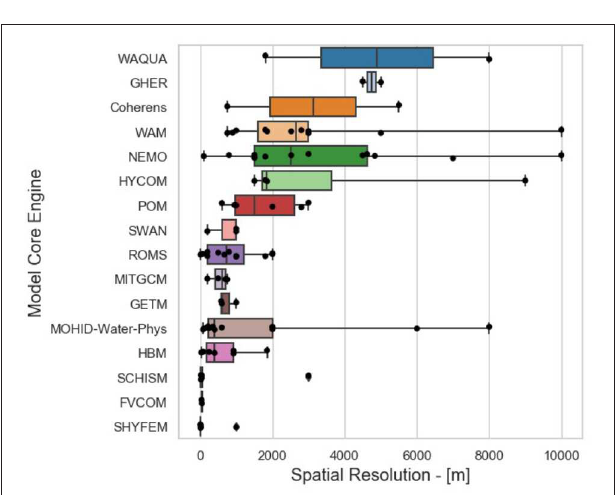
FIGURE 7 | Spatial resolution of the ocean hydrodynamics and waves (WAM and SWAN) model implementations presented in the survey (cf. Table 2 for model